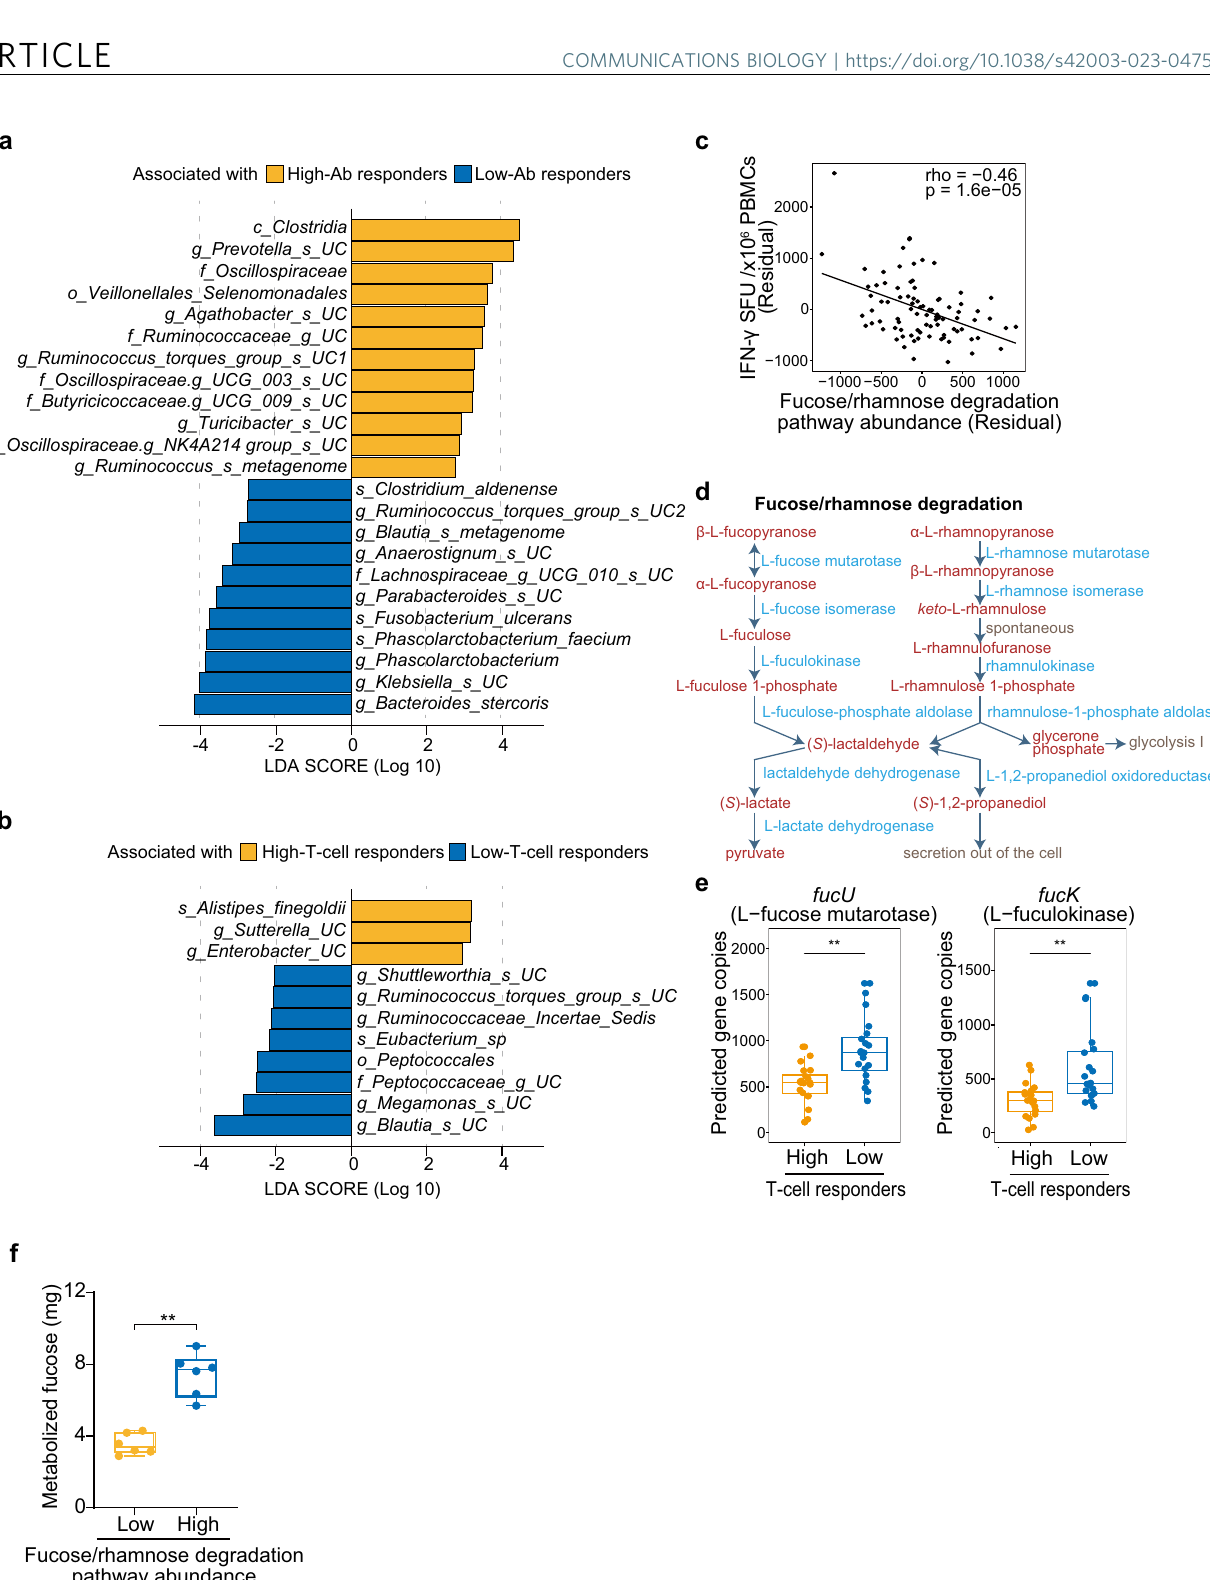
Fig. 6 Gut microbes associated with BNT162b2-induced adaptive immunity. Microbiomes of stool samples were analyzed by 16 S ribosomal RNA gene sequencing. a , b LEfSe analysis of gut microbes that were differentially abundant in high- vs low-antibody (Ab) responders ( a ) and in high- vs low-T-cell responders ( b ) in the entire cohort ( n = 20 each). c, class; o, order; f, family; g, genus; s, species; UC, unclassi fi ed. c Scatterplot showing a correlation between the gut microbial fucose/rhamnose degradation pathway and vaccine-induced T-cell responses in the entire cohort ( n = 86). Partial correlation analysis with adjustments for age, sex, and stool sampling timing was performed with Spearman ’ s correlation tests. d Schematic showing the fucose/ rhamnose degradation pathway. Metabolites and enzymes involved in the pathway are shown in red and blue, respectively. e Analysis of the abundance of predicted gene copies for L -fucose mutarotase and L -fuculokinase in high- and low-T-cell responders ( n = 20 each) in the entire cohort. f Metabolized fucose levels in stool slurry incubated with fucose in vitro for 20 h. e , f P values were calculated with Wilcoxon rank-sum tests with Benjamini – Hochberg FDR correction (** P < 0.01). Boxes show median and 25th – 75th percentiles, and whiskers show the